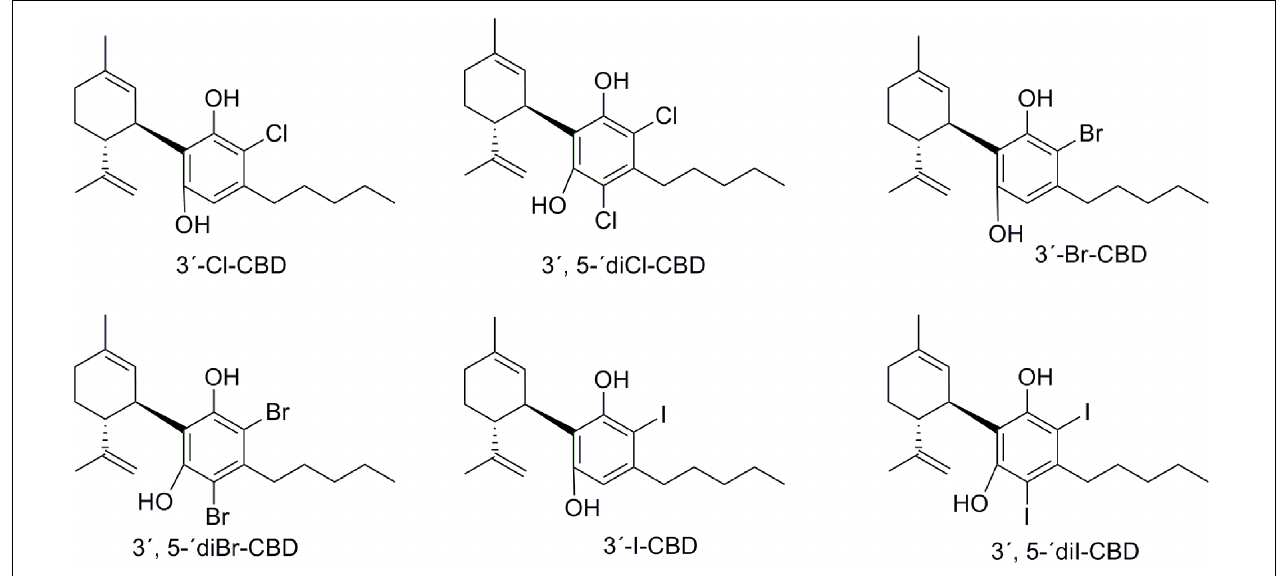
FIGURE 9 | Chlorinated, brominated, and iodinated CBD